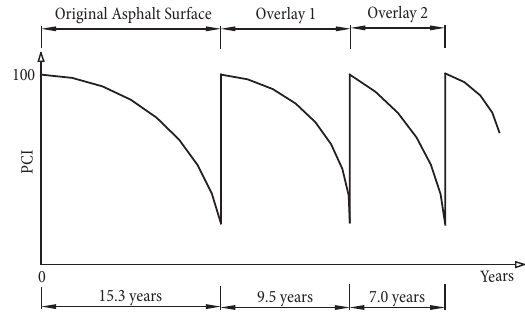
Fig. 2. Average age of asphalt surface before